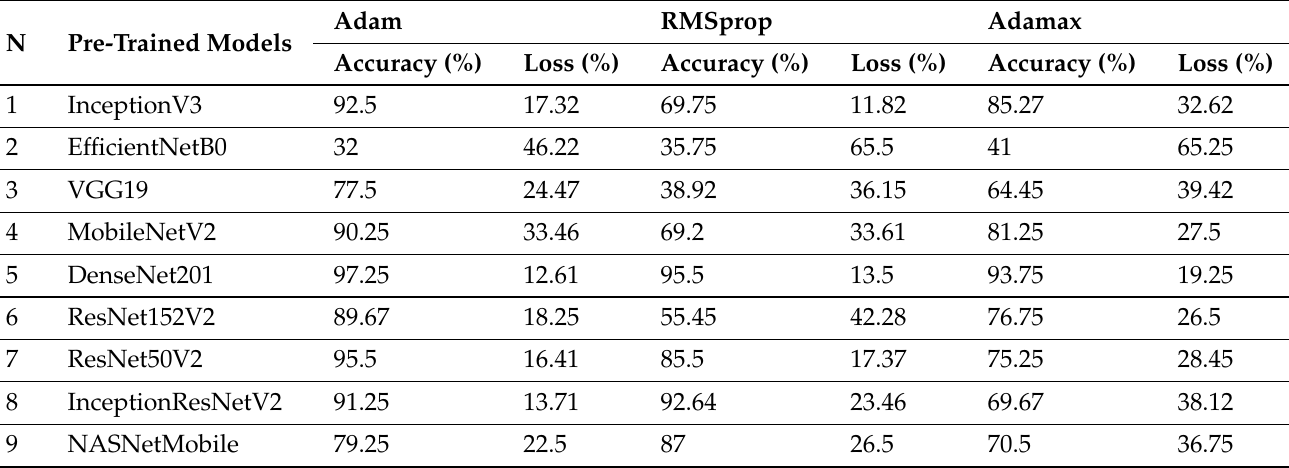
Table 2. The performance comparison of metrics using transfer-learning models with different